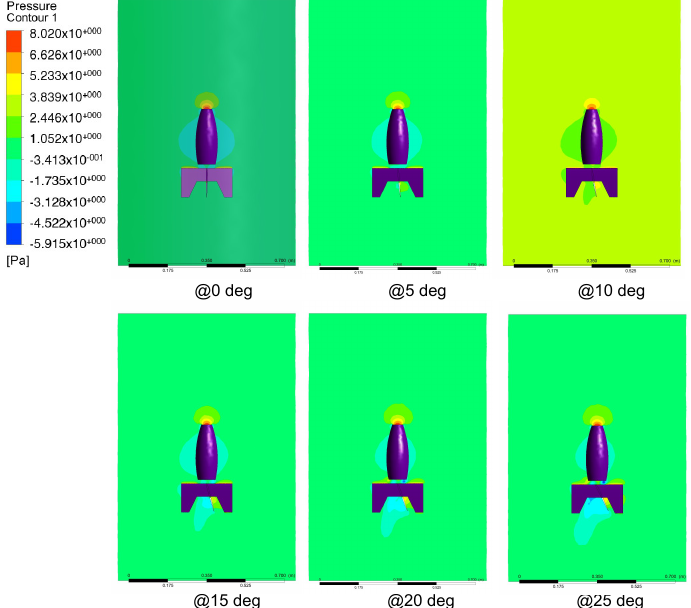
Figure 11. Pressure contours generated for MCR UAV v3.0 with a control-surface angle of deflection from 5 to 25 degrees for Aileron